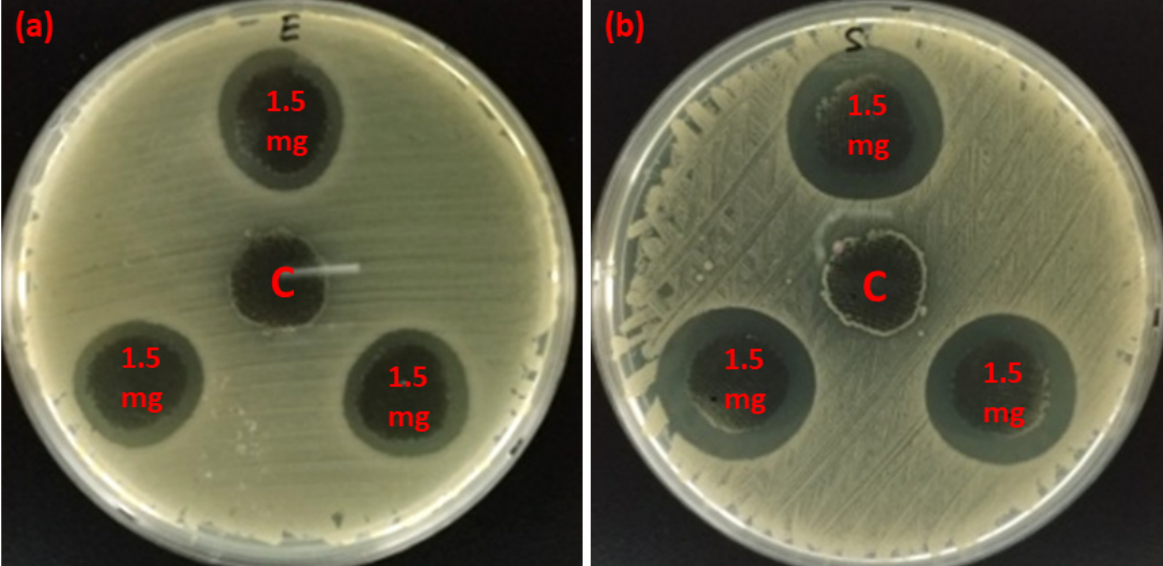
Figure 6. Zone of inhibition (ZOI) of sample E (containing 1.50 mg of synthesized silver nanocomposites) and control (C, containing 0.0 mg of synthesized silver nanocomposites) measured against ( a ) E. coli and ( b ) S. aureus microbial stains.